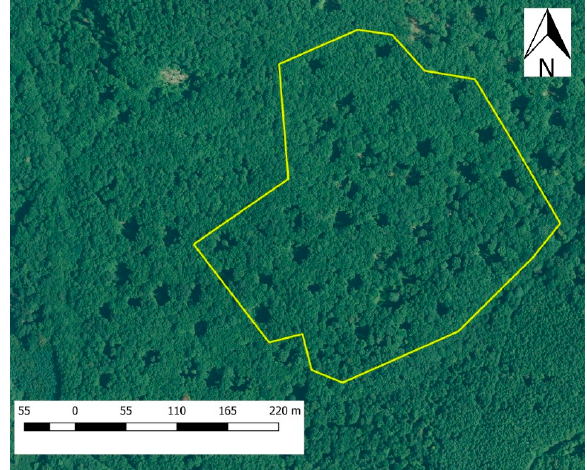
Figure 3. OS2 with an orthophoto from 2015 with a spatial resolution of 0.2 m.